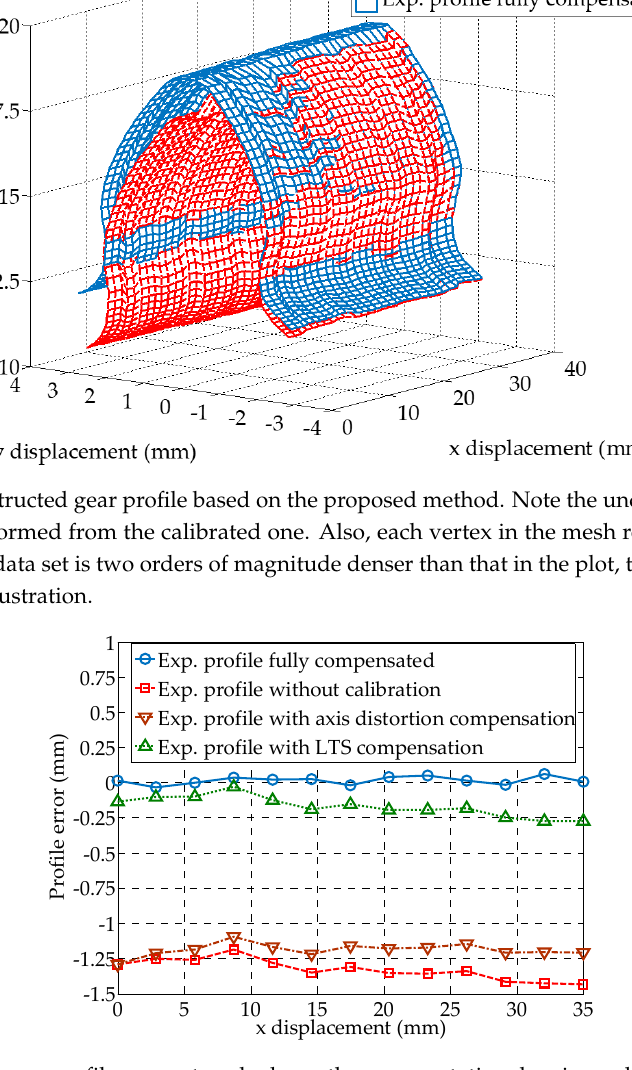
Figure 11. Average profile error trend along the gear rotational axis under four difference compensation settings.